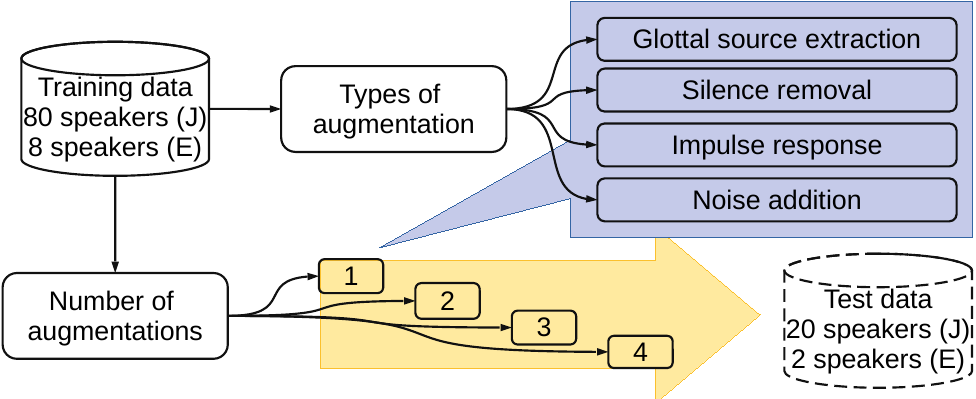
Figure 1. Flow of data selection for training speaker-independent SER in the experiments of data aug- mentation; J: Japanese (JTES); E: English (IEMOCAP); For text-independent, the split of training/test is based on sentences instead of